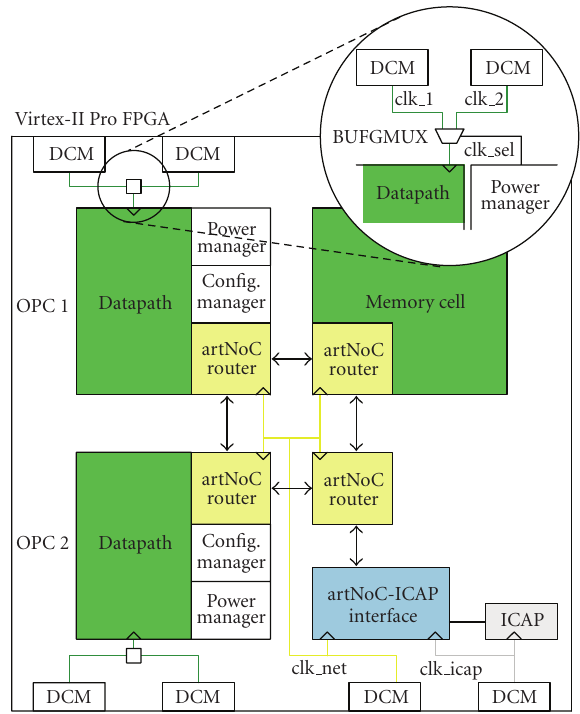
Figure 9: DodOrg FPGA floor plan/clock